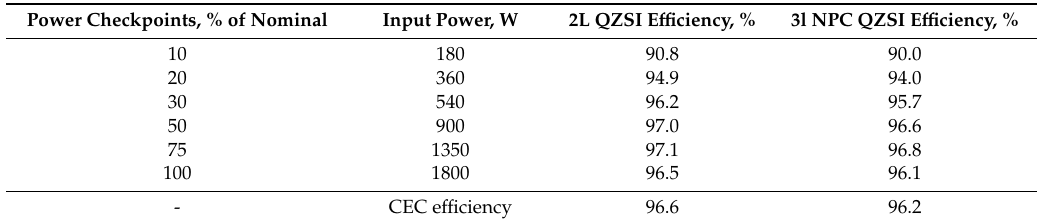
Figure 9. E ffi ciency evaluation of the 2L QZSI and the 3L NPC QZSI under di ff erent solar irradiance Figure 9. Efficiency evaluation of the 2L QZSI and the 3L NPC QZSI under different solar irradiance (power) levels ( a ) and within input voltage operating range ( b ). (power) levels ( a ) and within input voltage operating range ( b ). Table 4. The CEC e ffi ciency of 2L QZSI and 3L NPC